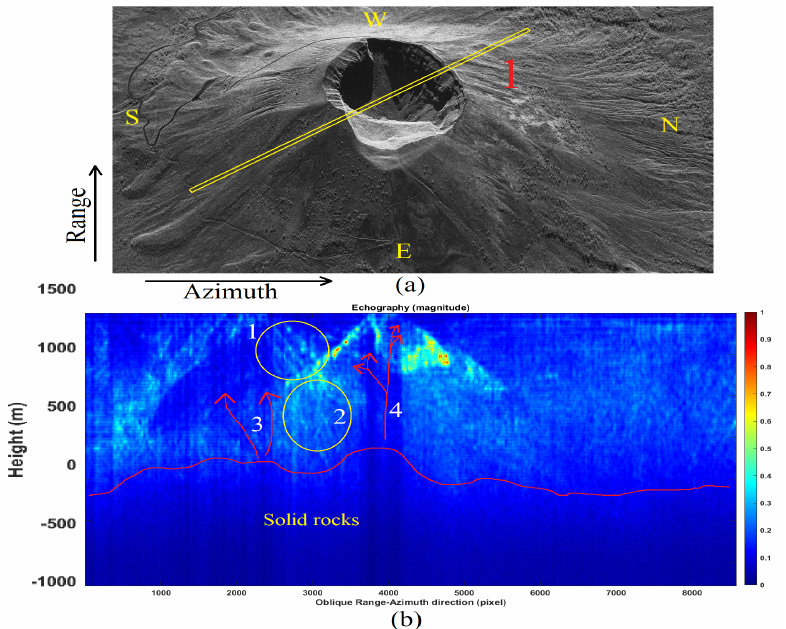
Figure 11. Range-azimuth line echographic tomography result (magnitude). ( a ) SLC SAR image (in magnitude). ( b ) Tomographic result (in magnitude). The yellow tomographic line is indicated by the number 1.